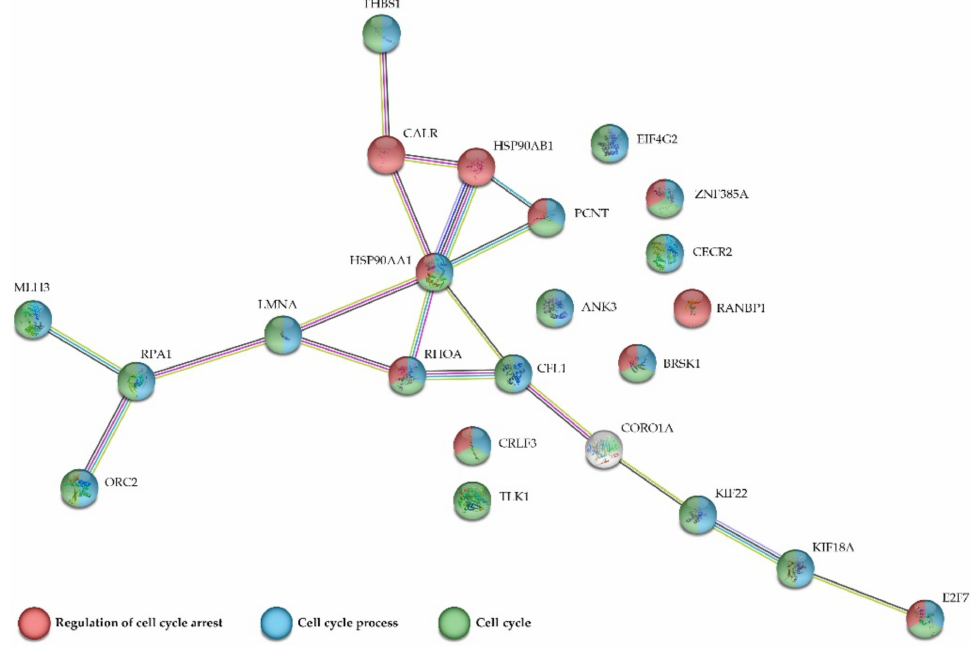
Figure 5. Network generated by the STRING database analysis. Interaction network of proteins involved in mentioned